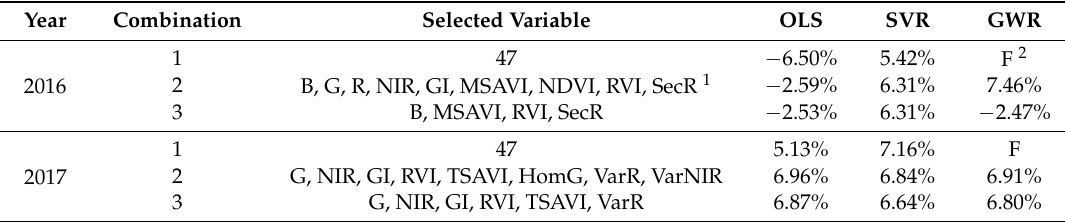
Table 5. Rice yield estimation in the first cultivations of 2016 and 2017 in Erlin. OLS—ordinary least squares; SVR—support vector regression; GWR—geographically weighted regression